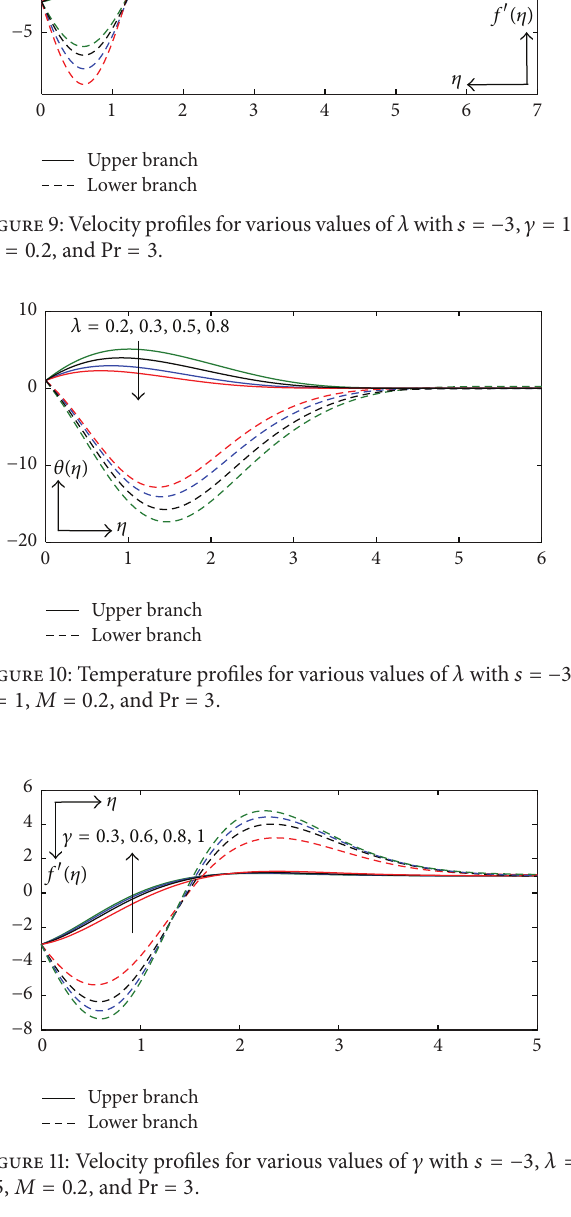
= 0.8, 0.5 , 0.3 , 0.2